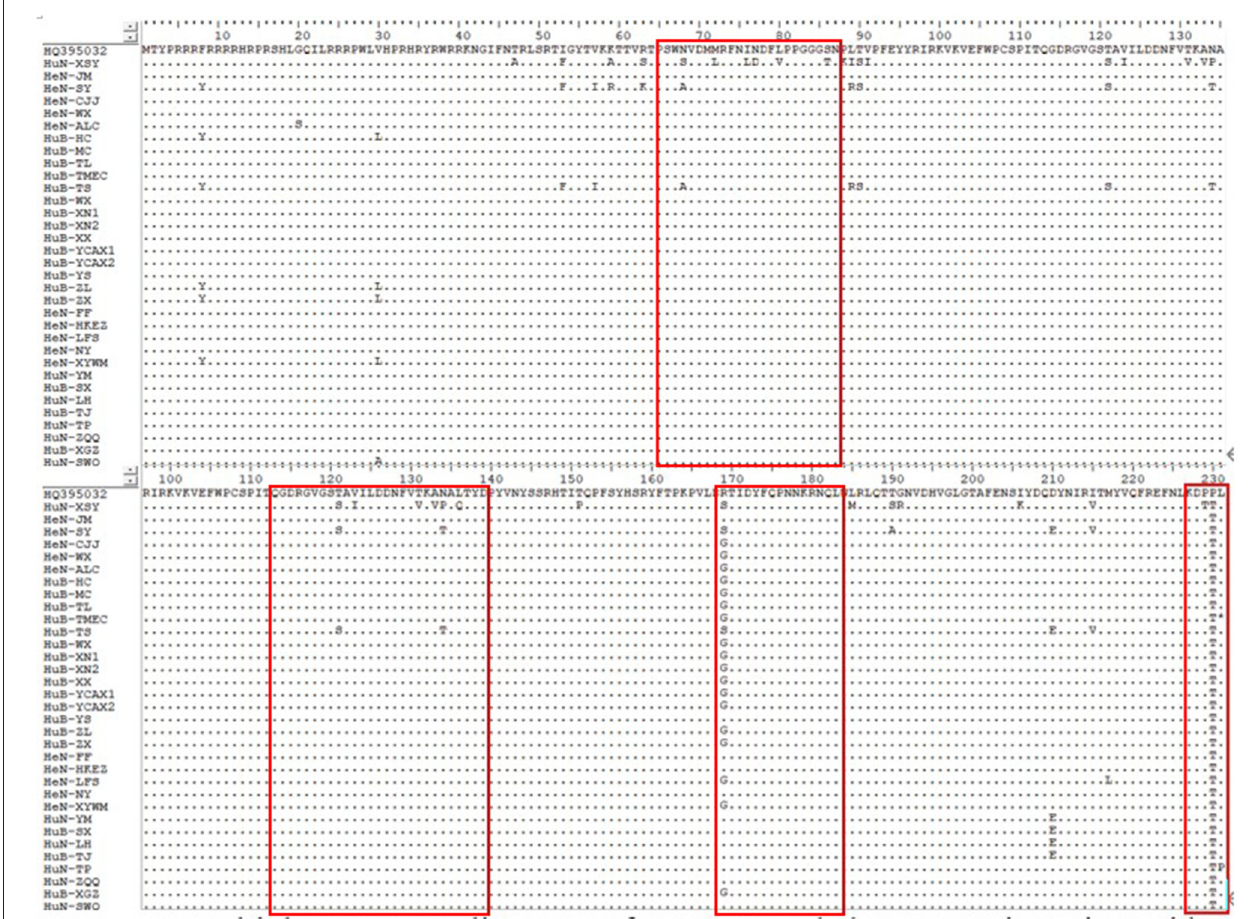
FIGURE 3 | Multiple sequence alignment of ORF2-encoded Cap protein amino acids of some strains. Epitopes are boxed.